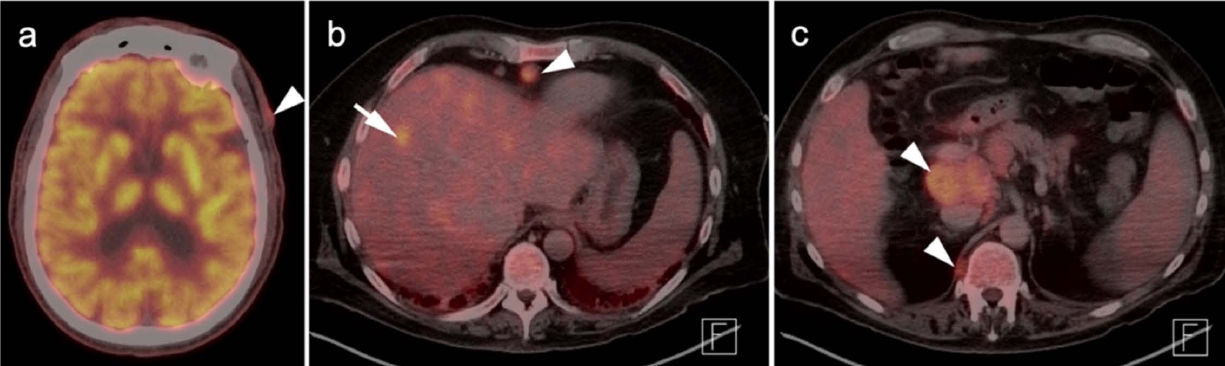
Figure 12. Metastatic Merkel cell carcinoma. ( a ) Axial FDG PET-CT image of the head. The primary tumor in the skin of the left temple (white arrowhead) is small but metabolically active. ( b ) Axial FDG PET-CT of the upper abdomen shows multiple tiny hypermetabolic liver metastases (white arrow. ( c ) Axial FDG PET-CT of the mid-abdomen shows a large portocaval metastatic hypermetabolic nodal conglomerate and a small right retrocrural node (white